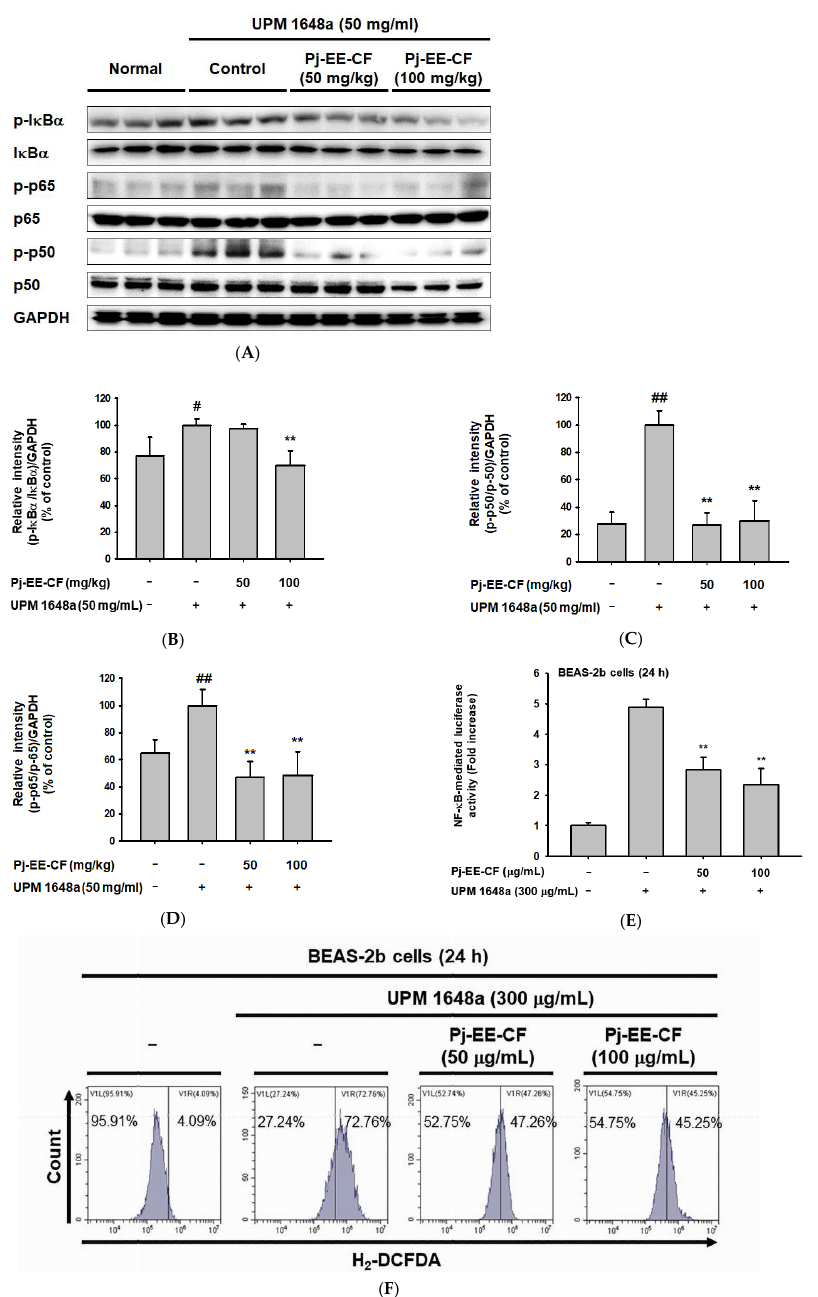
Figure 5. Inhibition of NF- κB signal by Pj -EE-CF. ( A ) Immunoblots of NF- κB signal molecules (Iκ ba, p65, p50) in UPM 1648a- and Pj-EE-CF-treated mouse lung tissues. Immunoblot images show all three biological replicates. NF- κB pathway-related molecules were detected using antibodies for total and phospho- forms of IκBα, p50, and p65. ( B – D ) Band intensity of the immunoblots was measured and quantitated through Image J software, and the relative intensity of the band is expressed as mean ± SD of the three biological replicates (n = 3 mice/group). ( E ) NF- κB luciferase assay in BEAS-2B cells treated with UPM 1648a (300 μg/mL) and Pj -EE-CF (0 –100 μg/mL) or UPM 1648a (300 μg/mL) alone. Data in ( E ) are presented as mean ± SD of the three samples. ( F ) BEAS-2B cells were treated with UPM 1648a (300 μg/mL) and Pj -EE-CF (0 –100 μg/mL) or UPM 1648a (300 μg/mL) alone and labeled with DCFDA. Fluorescence of DCFDA was detected by flow cytometry. # p < 0.05 and ## p < 0.01 compared to normal (non-treatment), ** p < 0.01 compared to control (UPM 1648a alone).